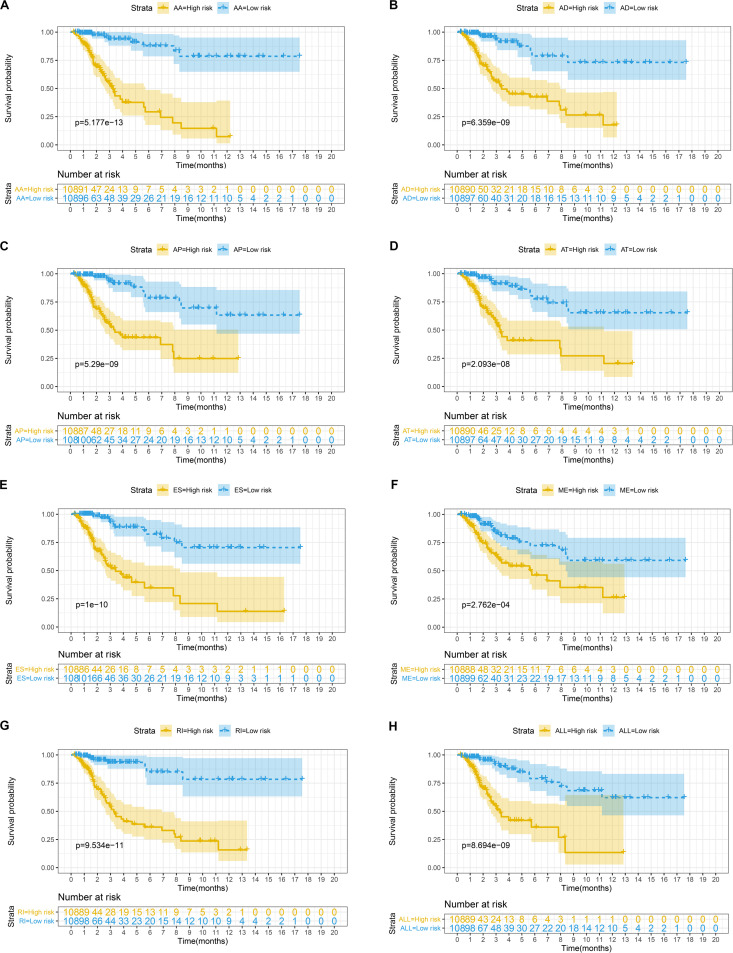
(A–G) Kaplan-Meier curves of prognostic predictor constructed with seven types of AS events in CC patients, respectively. The yellow line indicates a high-risk group; the blue line indicates a low-risk group. (H) Kaplan-Meier curves of the final prognostic predictor built with all survival associated candidates AS events in the seven types in CC patients. The yellow line indicates a high-risk group; the blue line indicates a low-risk group.